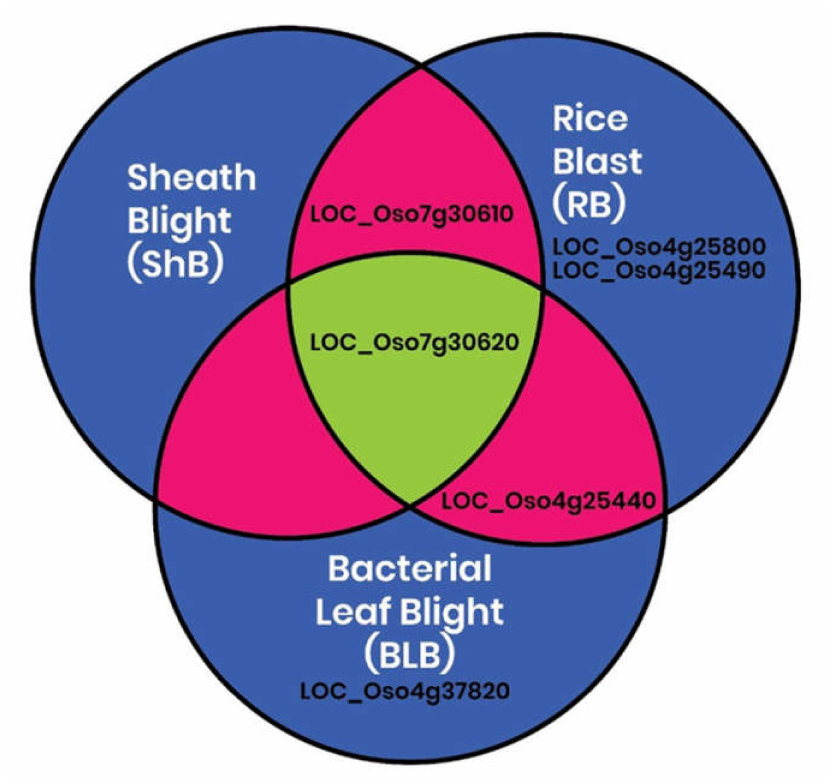
Figure 5. In silico prediction of 6 (out of 41) upregulated rice cytokinin-O-glucosyltransferase genes specific to sheath blight (RSB) and rice blast (RB bacterial leaf blight